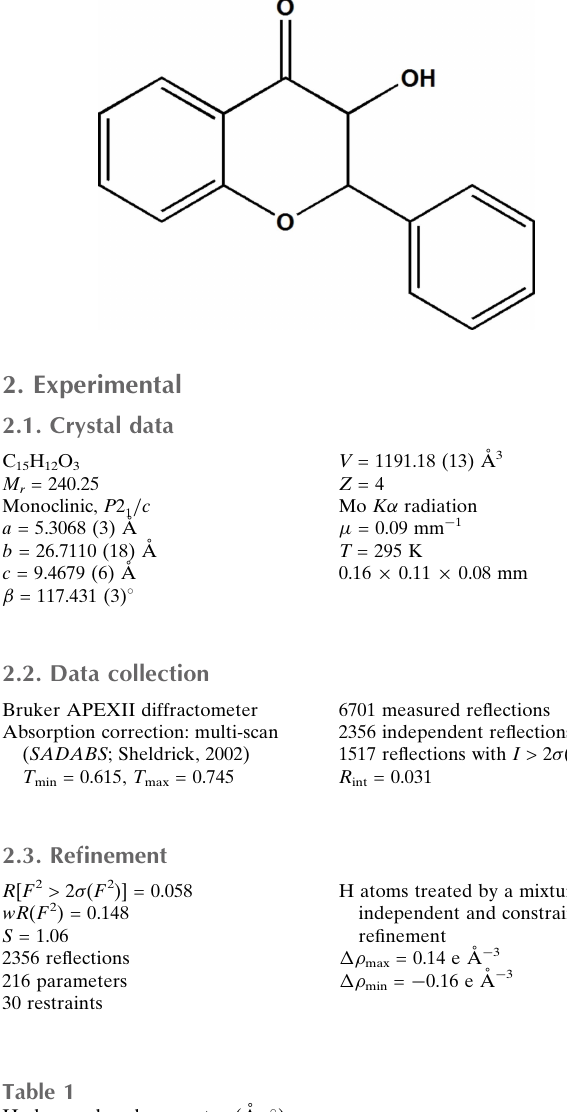
Hydrogen-bond geometry (A˚ , (cid:2)